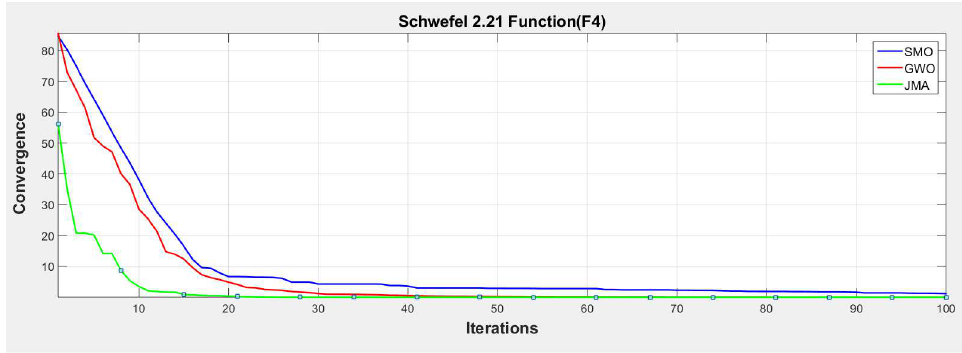
Figure 2. Convergence Curve for Schwefel 2.21 Function (F4).